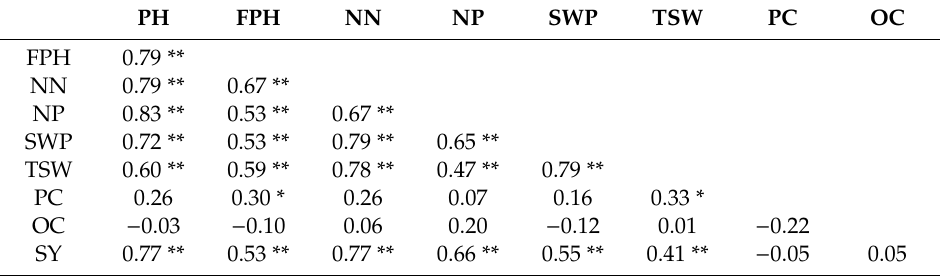
Table 4. Correlation matrix (Pearson) between the studied traits for both years ( n = 48). PH FPH NN